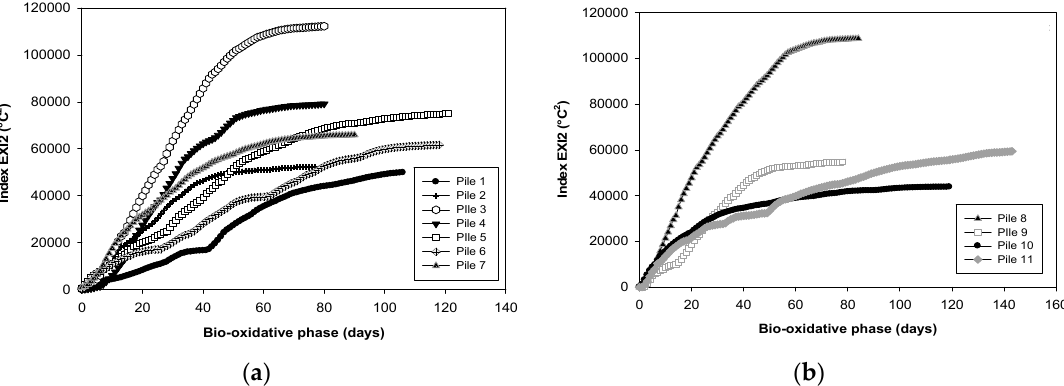
Figure 2. ( a ) Evolution of the cumulative values of EXI 2 during the bio-oxidative phase in the sewage sludge-derived composting mixtures; ( b ) Evolution of the cumulative values of EXI 2 during the bio-oxidative phase in the agri-food sludge-derived composting mixtures. Table 4. Indicators of the exothermic behaviour of the composting mixtures.